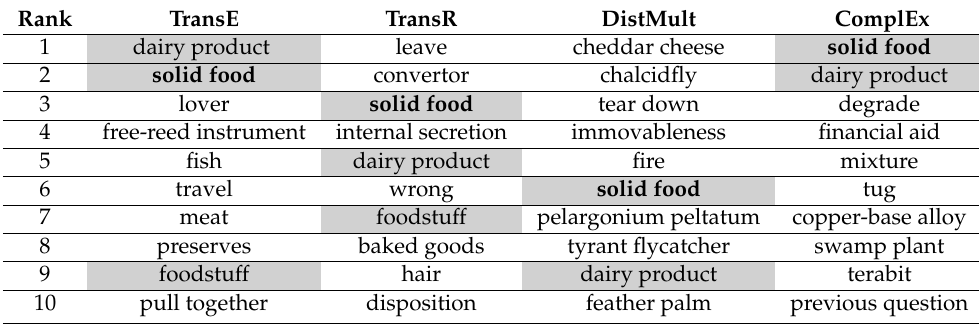
Figure 1. Overall process of knowledge base completion by knowledge graph embedding committee. Table 2. Top-10 candidate triples for a head entity yogurt and a relation hypernym . Different embeddings suggest different entities as a tail for yogurt and hypernym